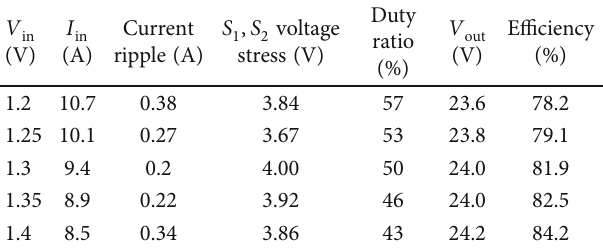
Table 6: Experimental results under seawater battery output conditions.